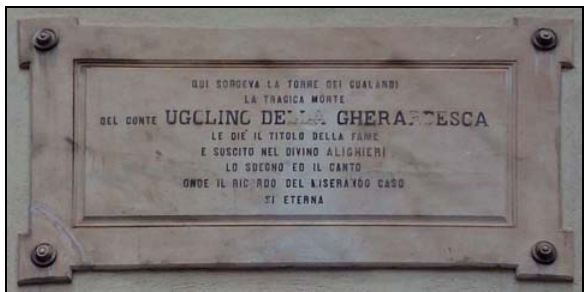
Figure 4 – Stone plate reminding the tragedy of Earl Ugolino and his family, and its narration in "La Divina Comedia" Dante Alighieri's masterpiece (see Figure 3, red dotted